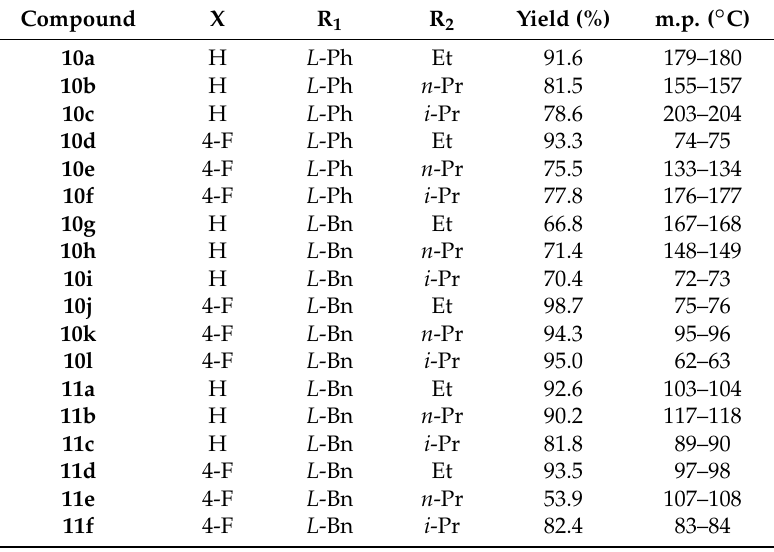
Table 1. Structure, yield, and melting point of novel thioureas 10 and 11